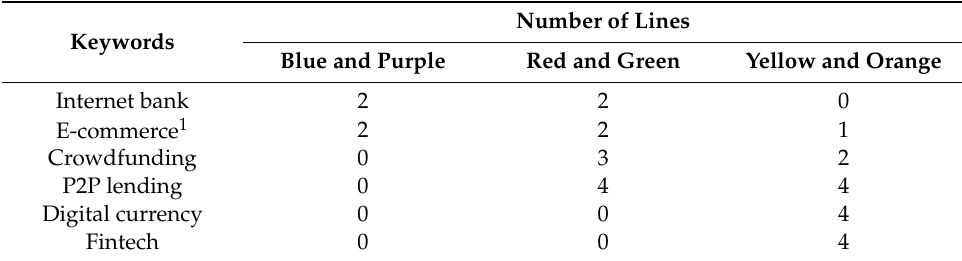
Table 2. Number and color of each pattern directly connected to